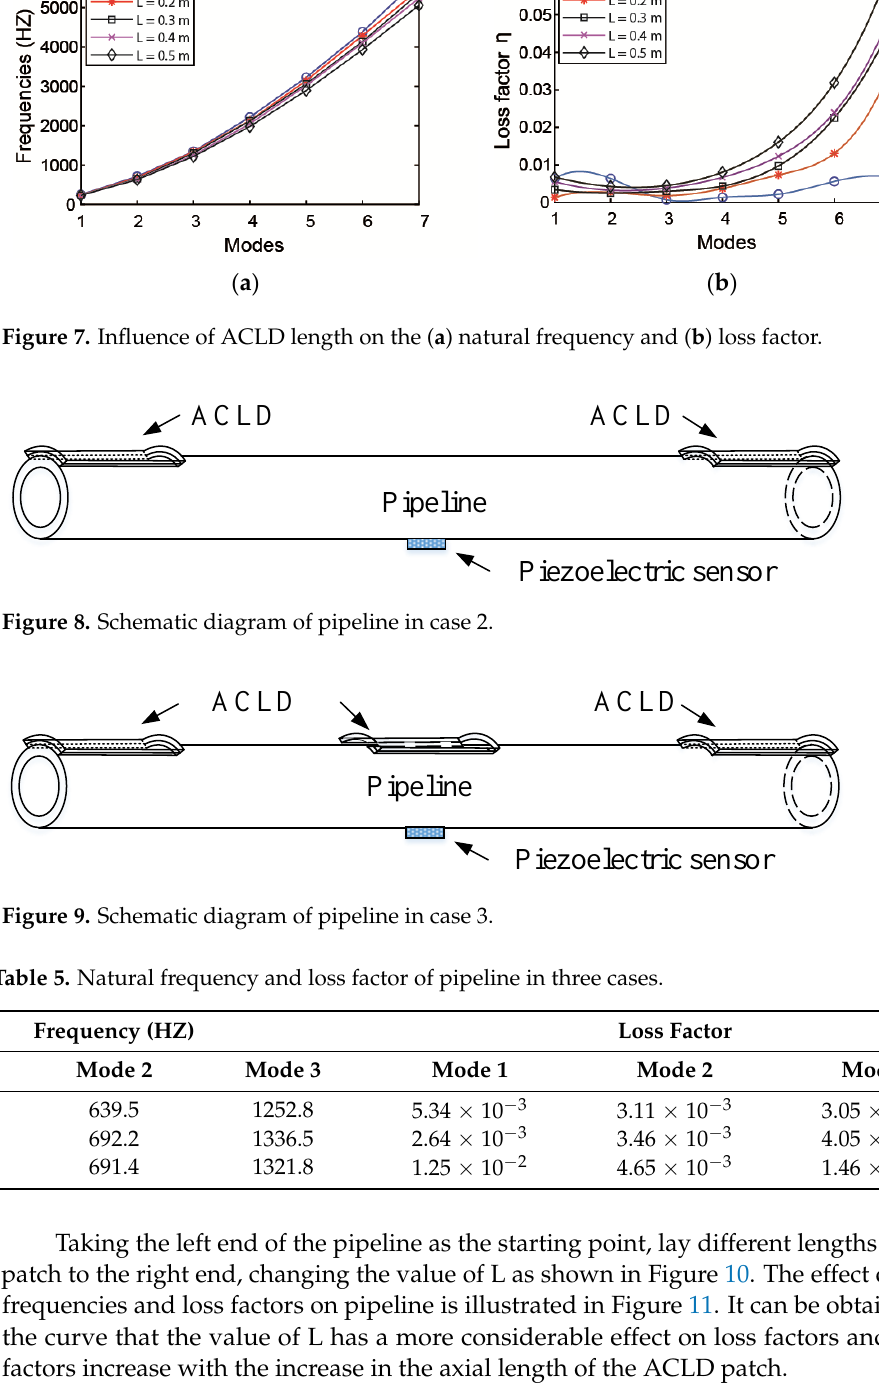
( a ) ( b ) Figure 11. The influence of axial length of ACLD on the ( a ) natural frequency and ( b ) loss factor. 3.2.4. The Influence of Voltage To verify the influence of the voltage value on the active constraining layer of pipe- line vibration control, different control voltages are applied on the piezoelectric constraint layer, and the vibration reduction performance of the active restraint layer under different control voltages is compared. In this study, the constant acceleration amplitude excitation is used, and the acceleration a = 0.2 g. The acceleration response value of the middle node of pipeline is extracted. Figure 12 shows the results. ( a ) ( b ) Figure 12. Vibration response in the ( a ) time domain and ( b ) frequency domain under different control voltages. The results presented in Figure 12 show that with the increase in voltage, the accel- eration response of pipeline first decreases and then increases. In other words, the damp- ing effect of control voltage on pipeline first increases then decreases. The results of the